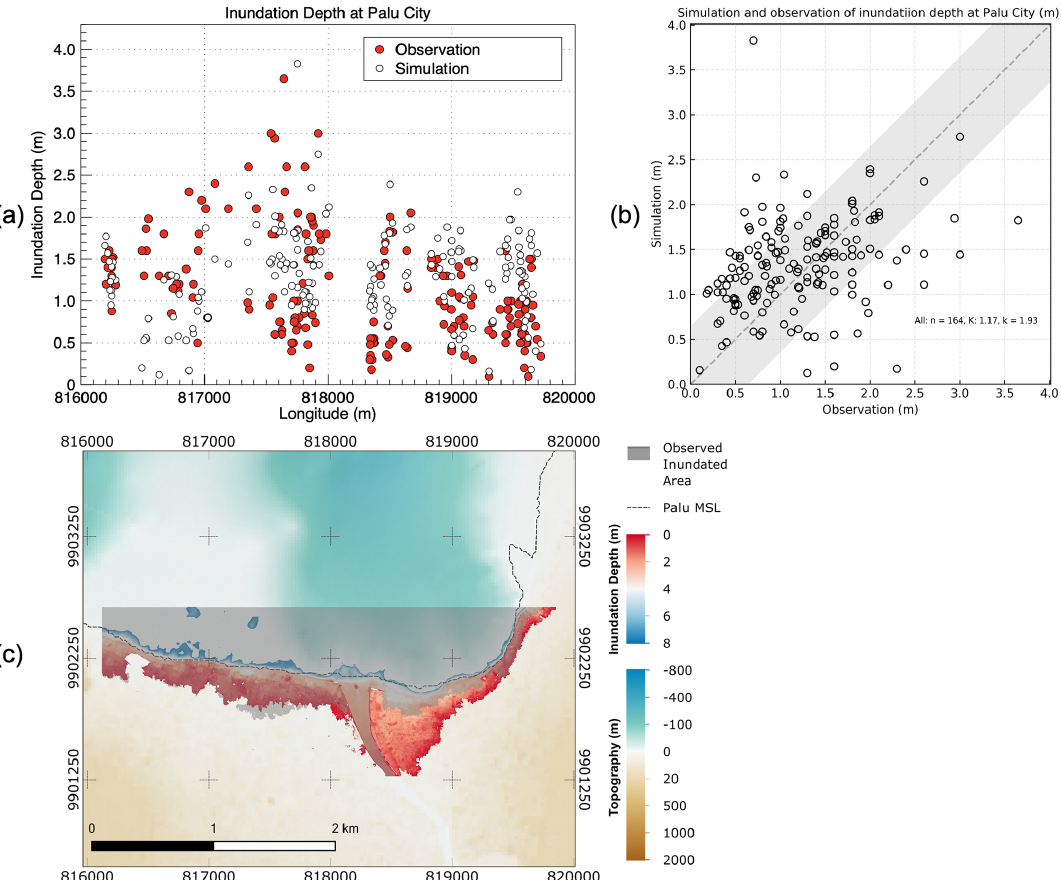
Figure 9. Tsunami inundation depths and the area around Palu city. (a) Simulated inundation depths and observation depths by Paulik et al. (2019) plotted over longitude. (b) Comparison between the simulated and observed tsunami inundation, as well as the comparison index, K , and κ values. n stands for the total number of observations. (c) Simulated tsunami inundation area (in color) and the observed inundation area retrieved from Gusman et al. (2019) (in